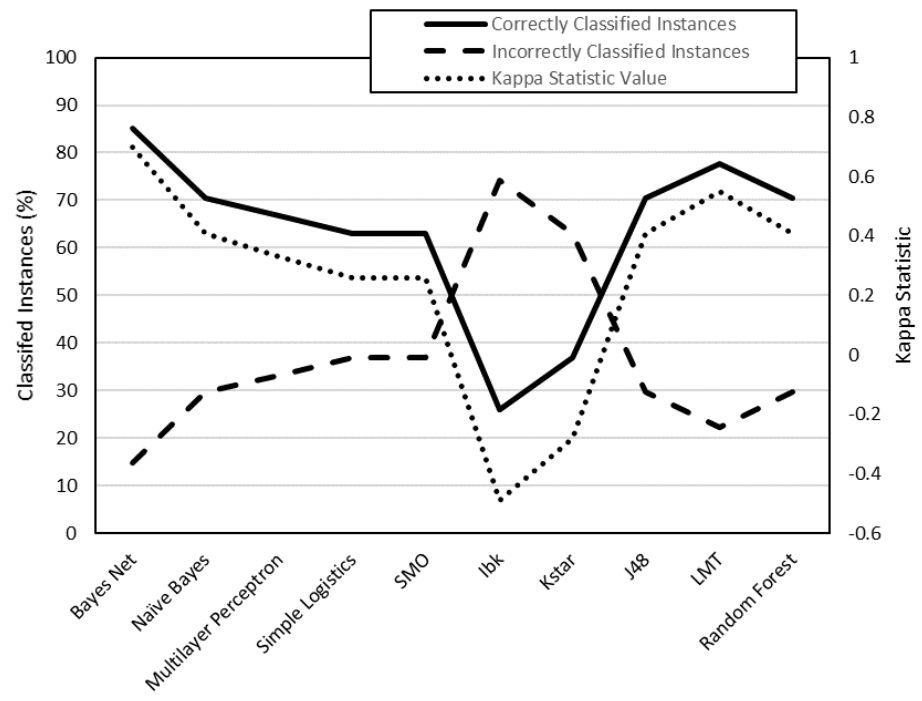
Figure 4. Evaluation of the models generated by WEKA for R a,90,XY data (cross-validation, 10 folds).